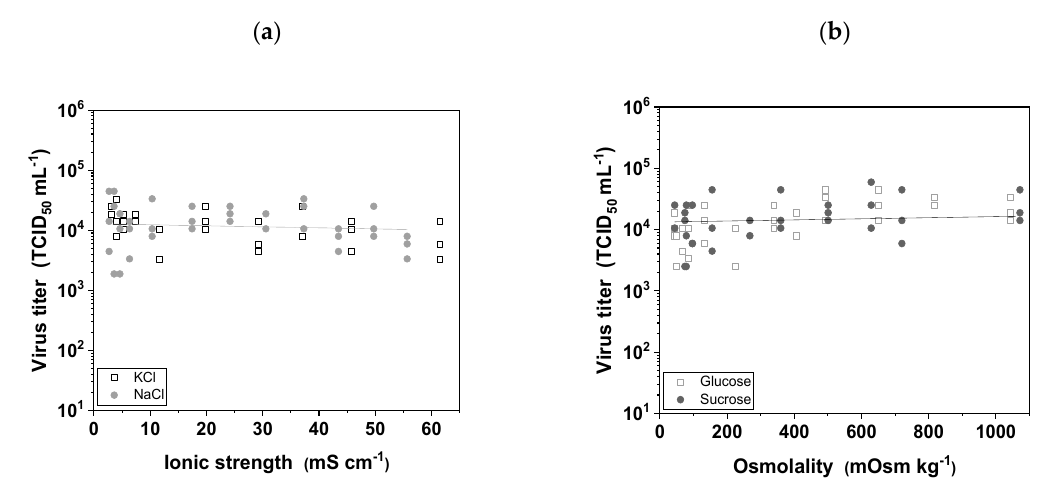
Figure 4. The influence of buffer ionic strength and osmolality on the infectivity of MV. Aliquots of the virus were diluted 1:10 in different salt and sugar solutions for 24 h at 4 °C. ( a ) NaCl and KCl solutions were used to determine the effect of buffer ionic strength. ( b ) Glucose and sucrose solutions were used to determine the effect of buffer osmolality. Experiments were conducted in triplicate, and all data points are shown.